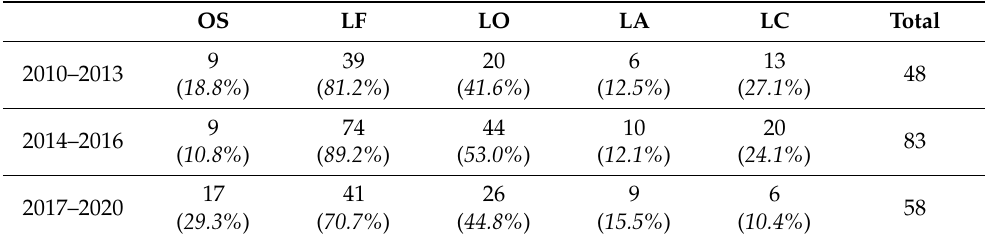
Table 2. The evolution of the number of operations performed